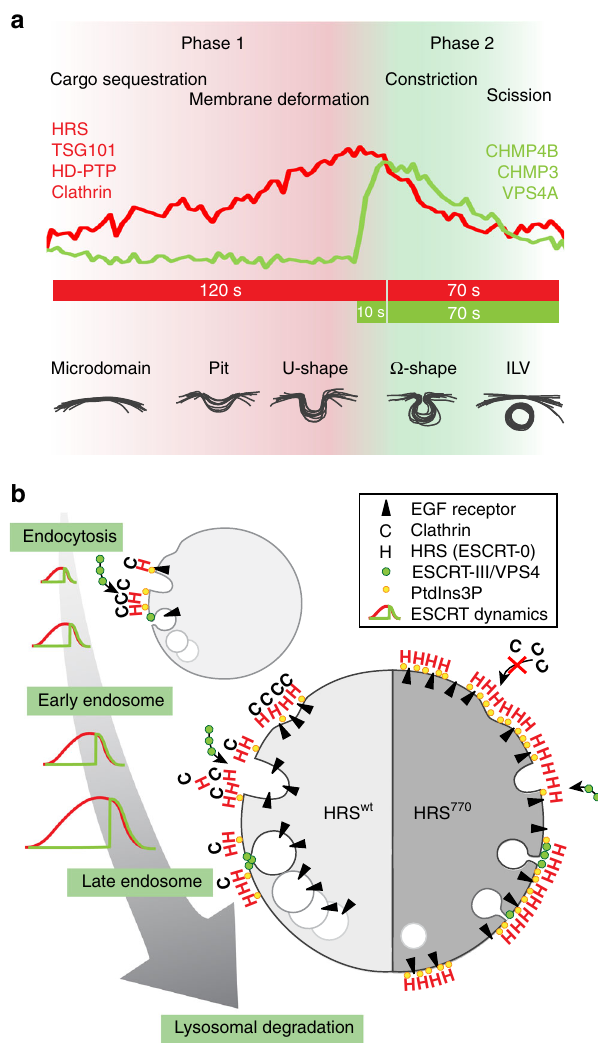
Fig. 9 Models of ESCRT-dependent ILV formation. a Model combining ESCRT kinetics with the timing of ILV formation. Phase 1: HRS and clathrin slowly accumulate on the endosome membrane, where they sequester cargo into a sorting microdomain, visible as an electron-dense EGFR-containing HRS/ clathrin coat. TSG101 and HD-PTP show similar undulating kinetics. Based on our fi ndings with the clathrin-binding mutant of HRS, we suggest that the fi rst phase comprises both cargo sorting and membrane deformation. Phase 2: ESCRT-III and VPS4A show a rapid accumulation which may re fl ect polymerization of ESCRT-III subunits and simultaneous recruitment of VPS4A, followed by a concerted dissociation of all ESCRT complexes. We suggest that the second phase may correspond to constriction and scission of ILVs. For details see Discussion. b Model of ESCRT-dependent ILV formation and the role of clathrin. Left: to ensure ef fi cient cargo degradation in lysosomes, ESCRT proteins and clathrin are recruited to endosomes as they mature, in a coordinated and repetitive wave-like pattern. Each wave (which lasts for about 200s) correlates with the formation of one ILV. Right: in the absence of endosomal clathrin, the wave dynamics are disturbed, ESCRT-0 and cargo accumulate on the endosomal membrane, and ILV formation is perturbed; the size of the forming bud is smaller, the forming ILV has a longer neck, and